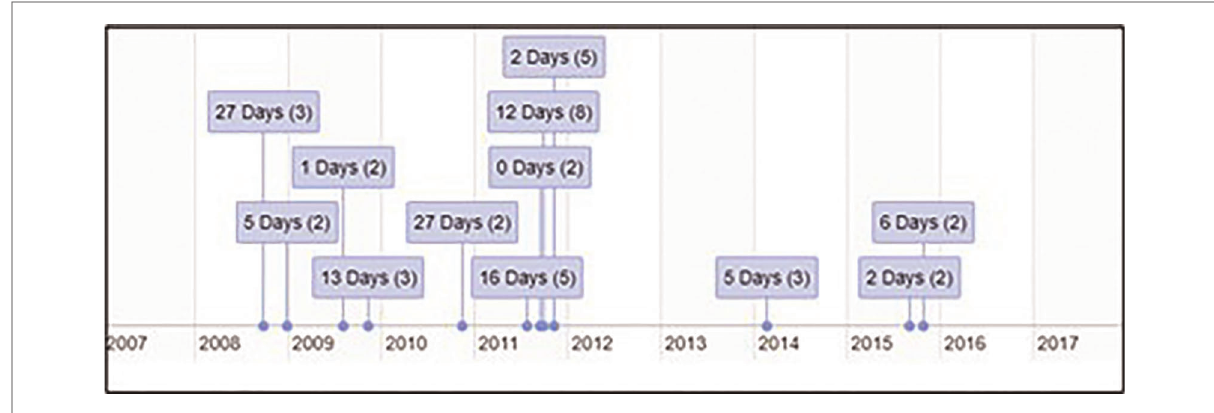
FIGURE 1 Timeline of suicide clusters occurring in County Cork during the period 2008 – 2017.